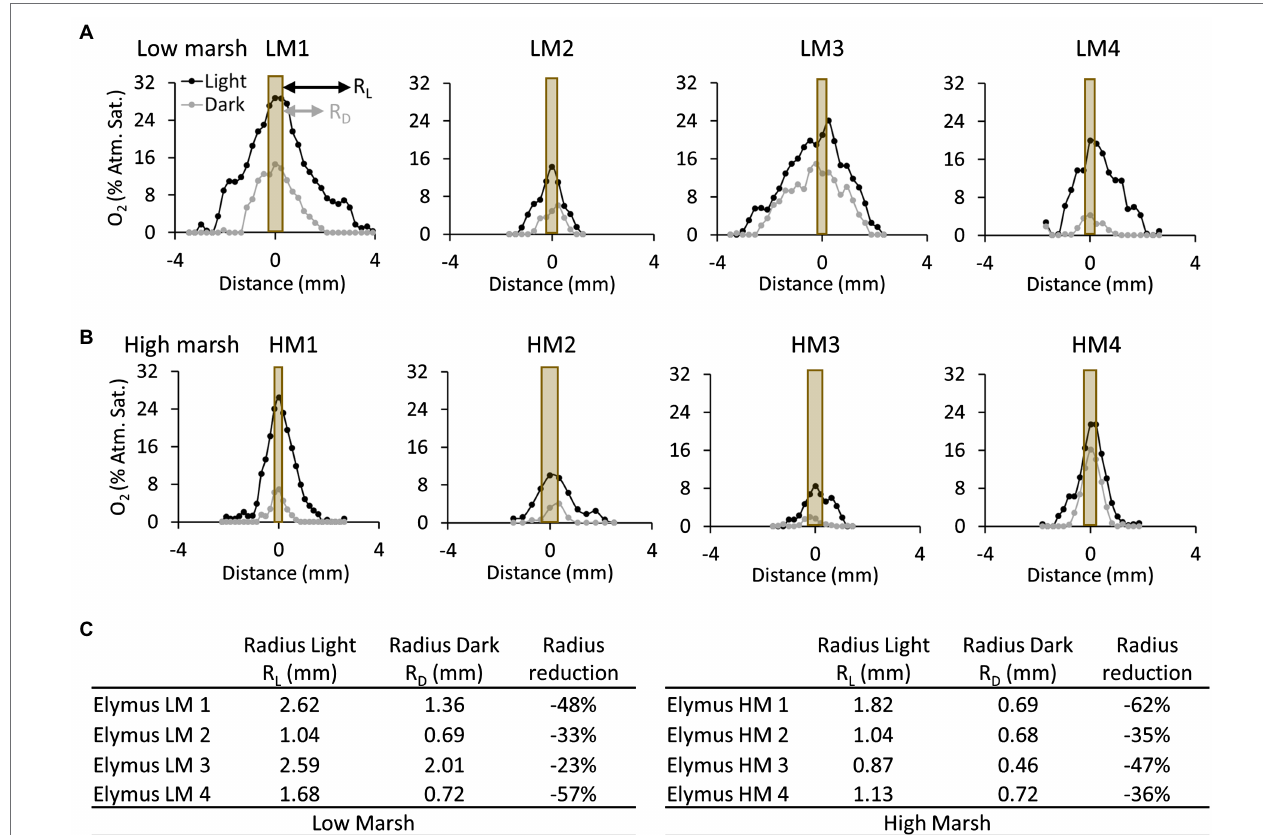
FIGURE 5 | Oxygen concentration profiles measured perpendicular to selected roots of the E. athericus low-marsh ecotype (A) and high-marsh ecotype (B) . The locations of the profiles are depicted in Figures 2 , 3 . The orange bar shows the position of the root relative to the O 2 profile, and the width of the bar represents the relative width of the root investigated. The profiles were measured during the last light cycle (2.5–3 d) and dark cycle (2–2.5 d), respectively, at the time point, when the oxygen concentration at the root surface was highest. (C) Table showing the radius of oxic root zones measured from the root surface to the bulk anoxic sediment in the low- and high-marsh ecotype during light and dark periods,